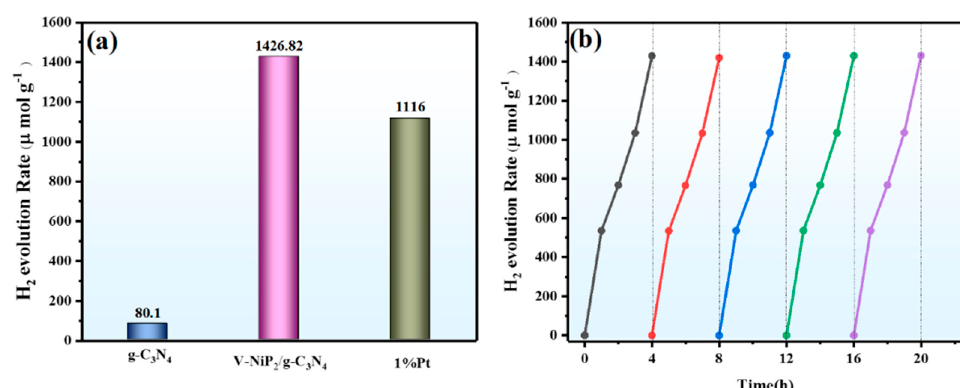
Figure 3. ( a ) Photocatalytic H 2 evolution rate of g-C 3 N 4 , V-NiP 2 /g-C 3 N 4 and 1%wt Pt/g-C 3 N 4 ; ( b ) The cycling stability experiments of photocatalytic H 2 evolution for V-NiP 2 /g-C 3 N 4 under visible light irradiation for 20 h.